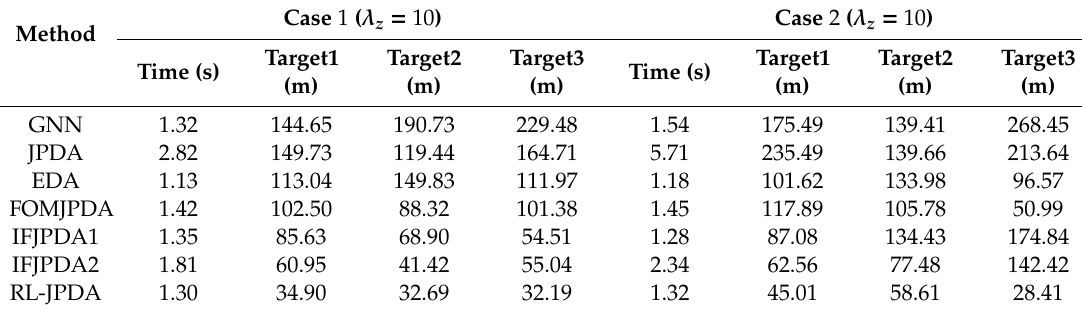
Table 3. RMS errors and execution time of the reentry vehicle